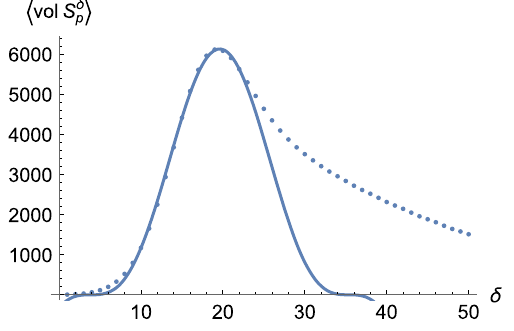
Fig. 5 The average shell volume (cid:2) v ol ( S δ p ) (cid:3) as a function of the dual link distance δ , at volume N 41 = 75 k . The δ -range where the data points are qualitatively well approximated by a sin 3 -function (contin- uous curve) gives us a rough estimate of the size of the region where the shell volumes display four-sphere behaviour. Plots at higher volume look similar. The fit shown is to 6127sin 3 ( 0 . 10 δ − 0 . 38 ) (including